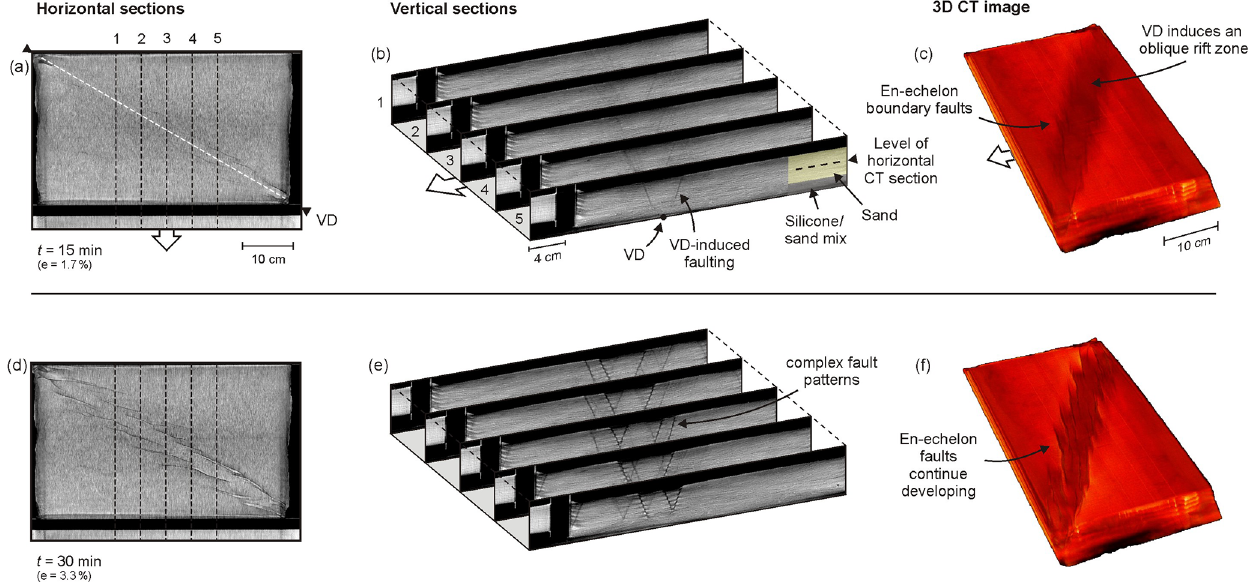
Figure 6. CT analysis of Model H (30 ◦ oblique VD, no crustal weaknesses simulated, CT-scanned rerun of Model G). (a, d) Horizontal sections through the brittle layer. (b, e) Serial cross sections. (c, f) 3D CT images. Note that the colours in these images represent CT- scanning intensities and are not to be interpreted as a measure of model surface